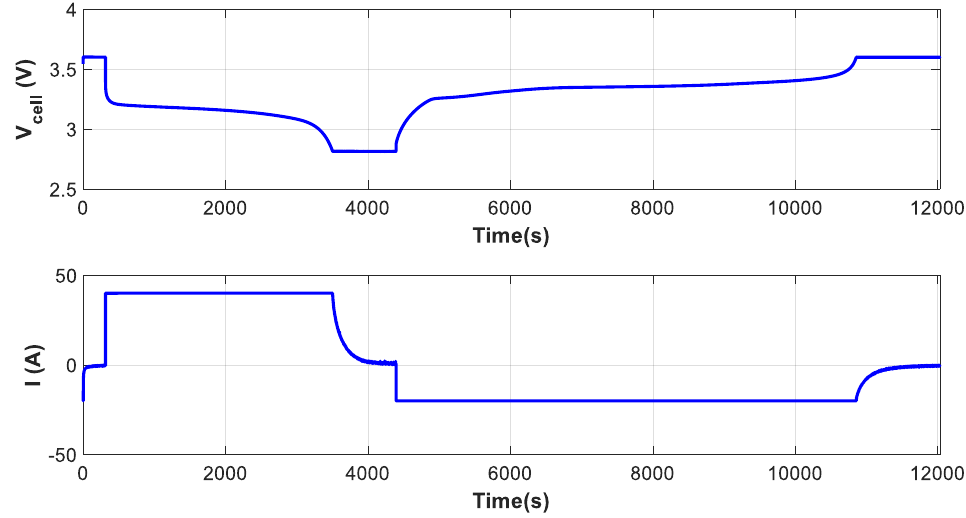
Figure 14. Cell voltage and current during the three phases experiment to measure the cell capacity.